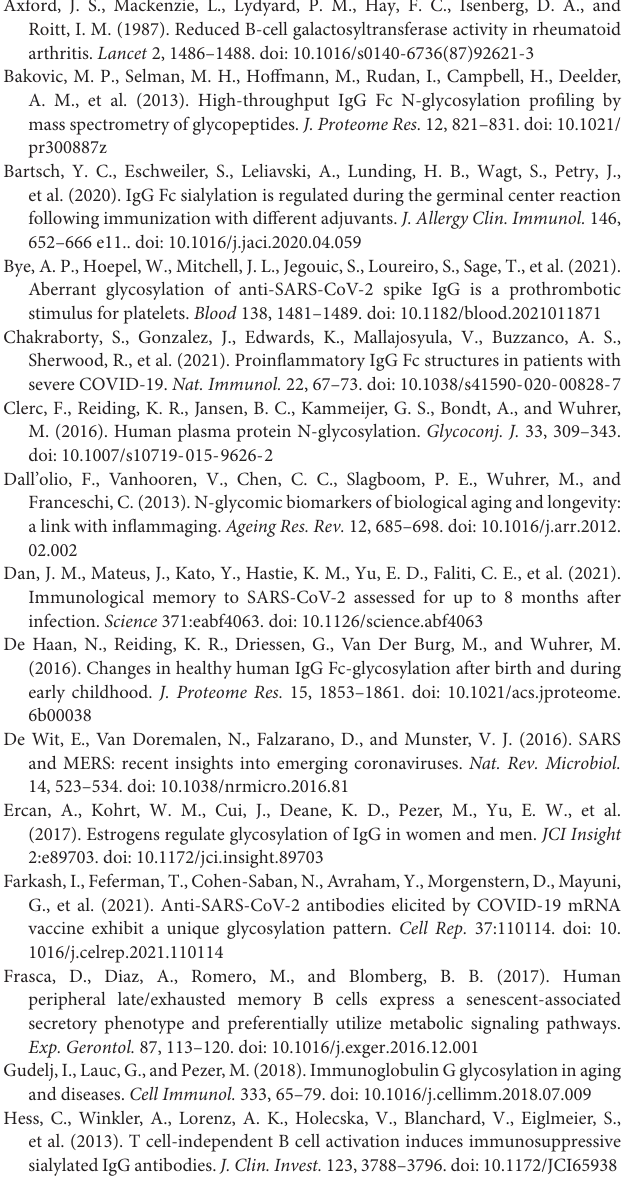
Ho, C. H., Chien, R. N., Cheng, P. N., Liu, J. H., Liu, C. K., Su, C. S., et al. (2015). Aberrant serum immunoglobulin G glycosylation in chronic hepatitis